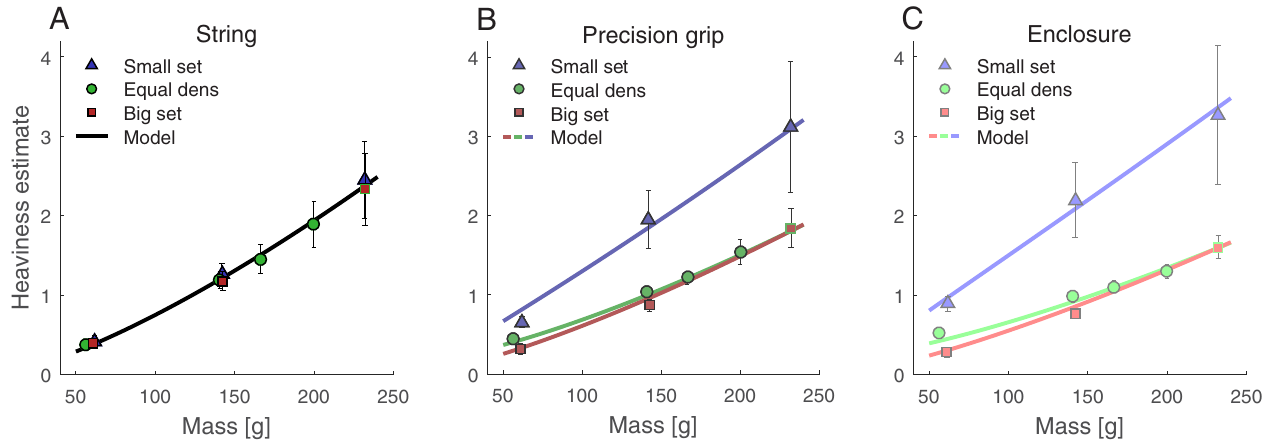
Fig 4. Main results of Experiment 2. Heaviness estimates averaged over individual heaviness scores with error bars denoting 95% confidence intervals of between- participant variability and lines being the model fit. (A, B, C): Heaviness estimates for different density sets as a function of mass with a different panel for every grip type (A: string, B: precision grip, C: